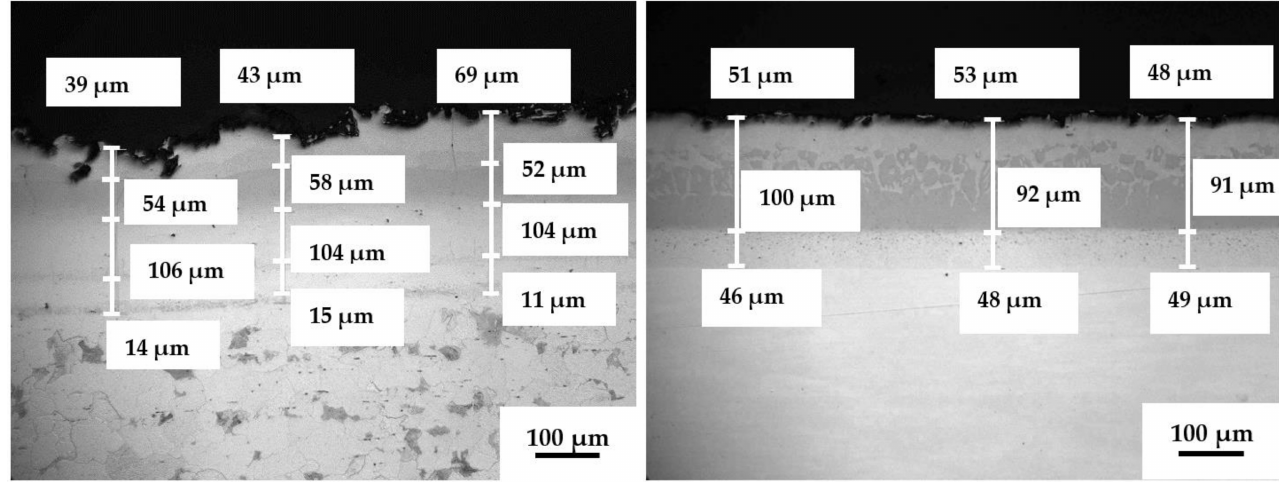
Figure 10. Microstructure of aluminized carbon steel (A)—left, and aluminized stainless steel 316L (6A)—right after exposure in H 2 S—air at 500 ◦ C for 504 h.